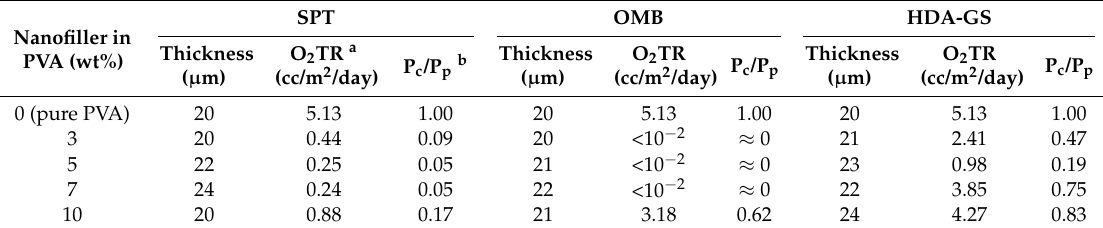
Table 2. Oxygen permeations of PVA hybrid films with various nanofiller contents. Nanofiller in PVA